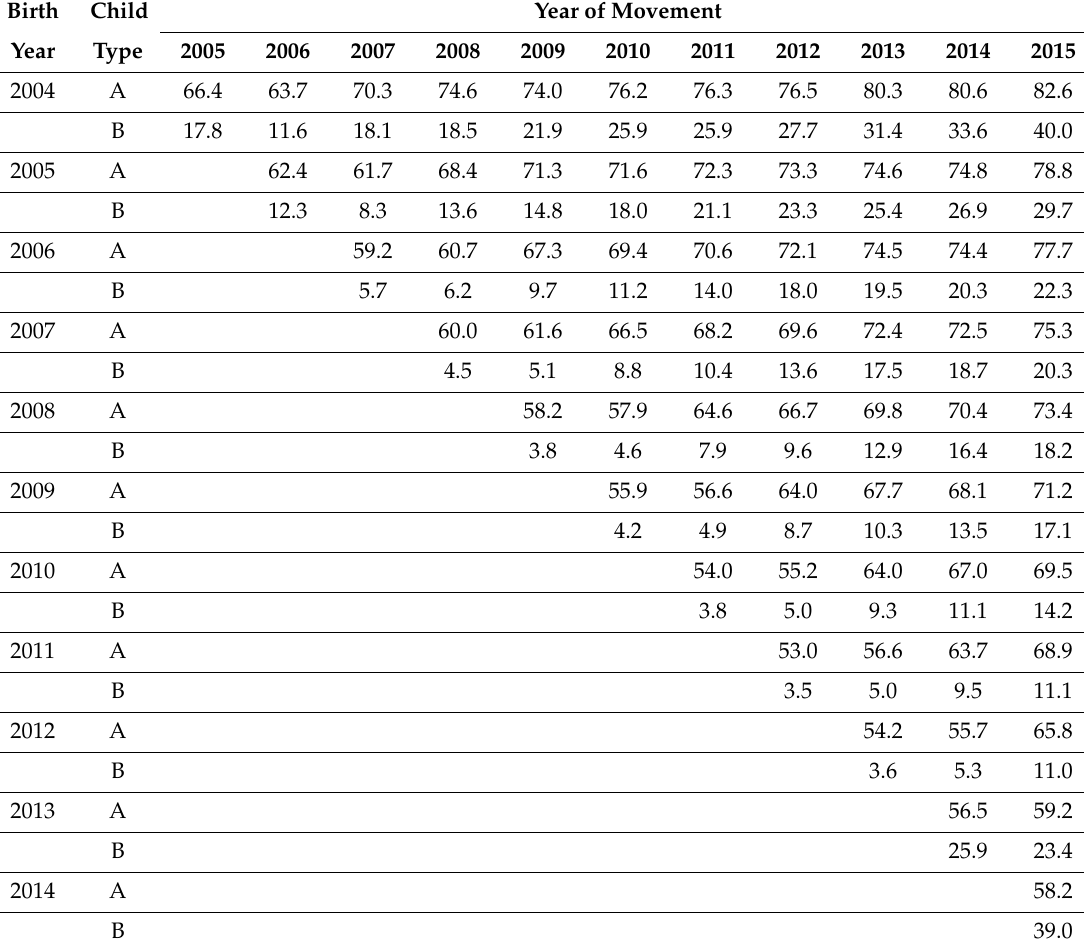
Table 2. Percentages of children who returned to Hong Kong in di ff erent